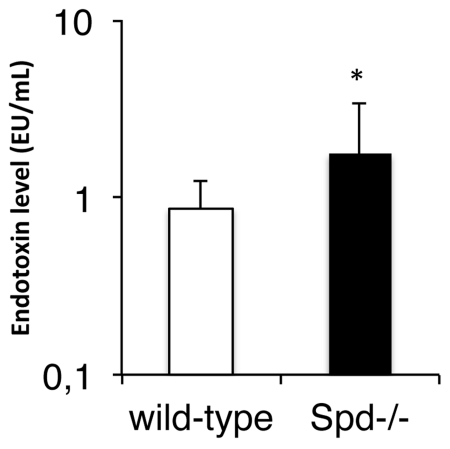
Serum endotoxin levels.Serum endotoxin levels were significantly increased in 16 SP-D deficient mice compared to 15 wild-type mice during the light phase period and fed a standard chow ad libitum. * p<0.05. Data were logaritmically transformed to obtain normality before testing. Data are means + standard deviations.